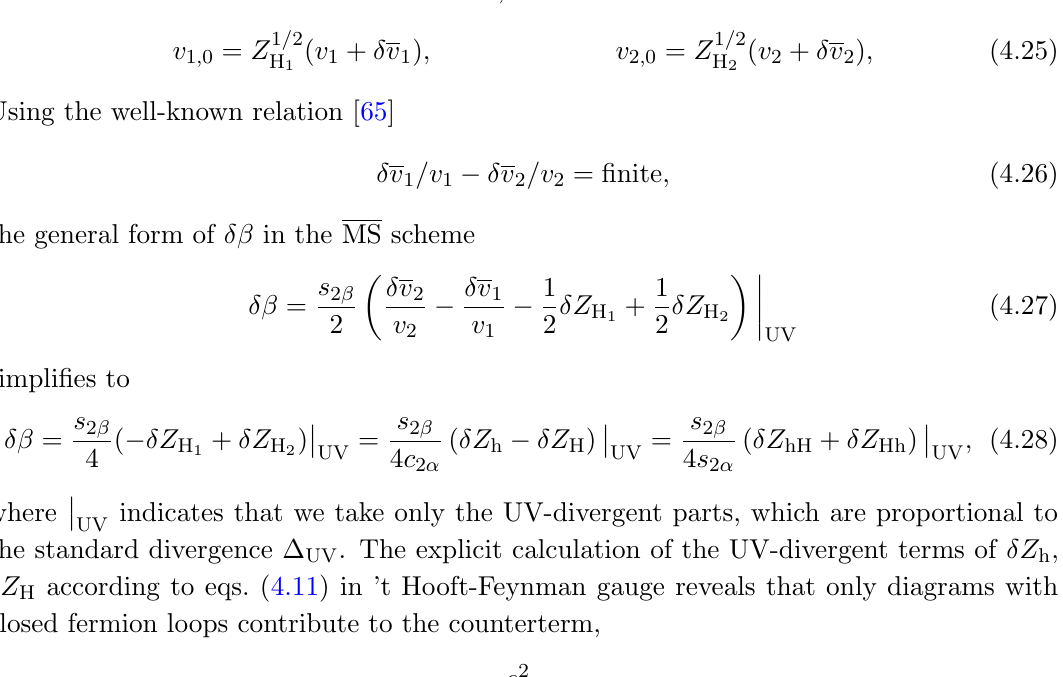
table 2. In the class of R (cid:24) gauges this result is gauge independent at one-loop order [39, 40]. Neutral Higgs